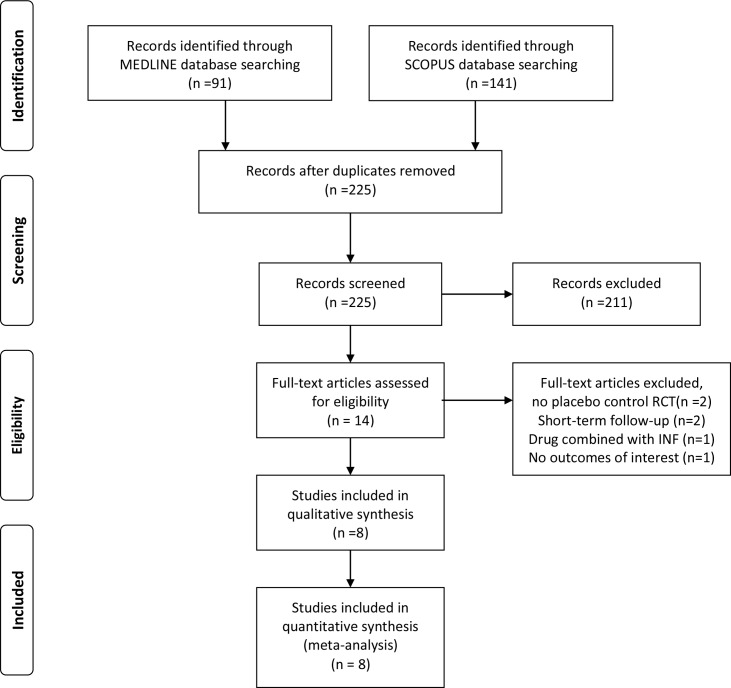
Flow chart presenting the selection of eligible studies.